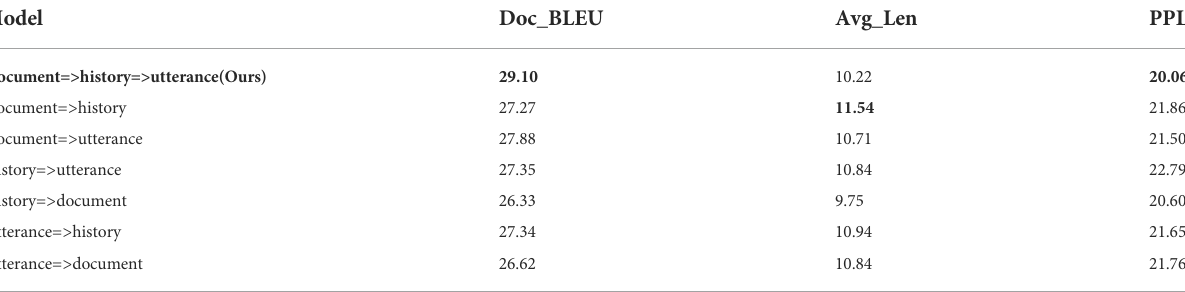
TABLE9Ablationstudyforthehierarchicaldecodingmoduleondocumentrelevanceandresponsequality.Thesymbol “ = > ” representsthedecoding order from the bottom up.